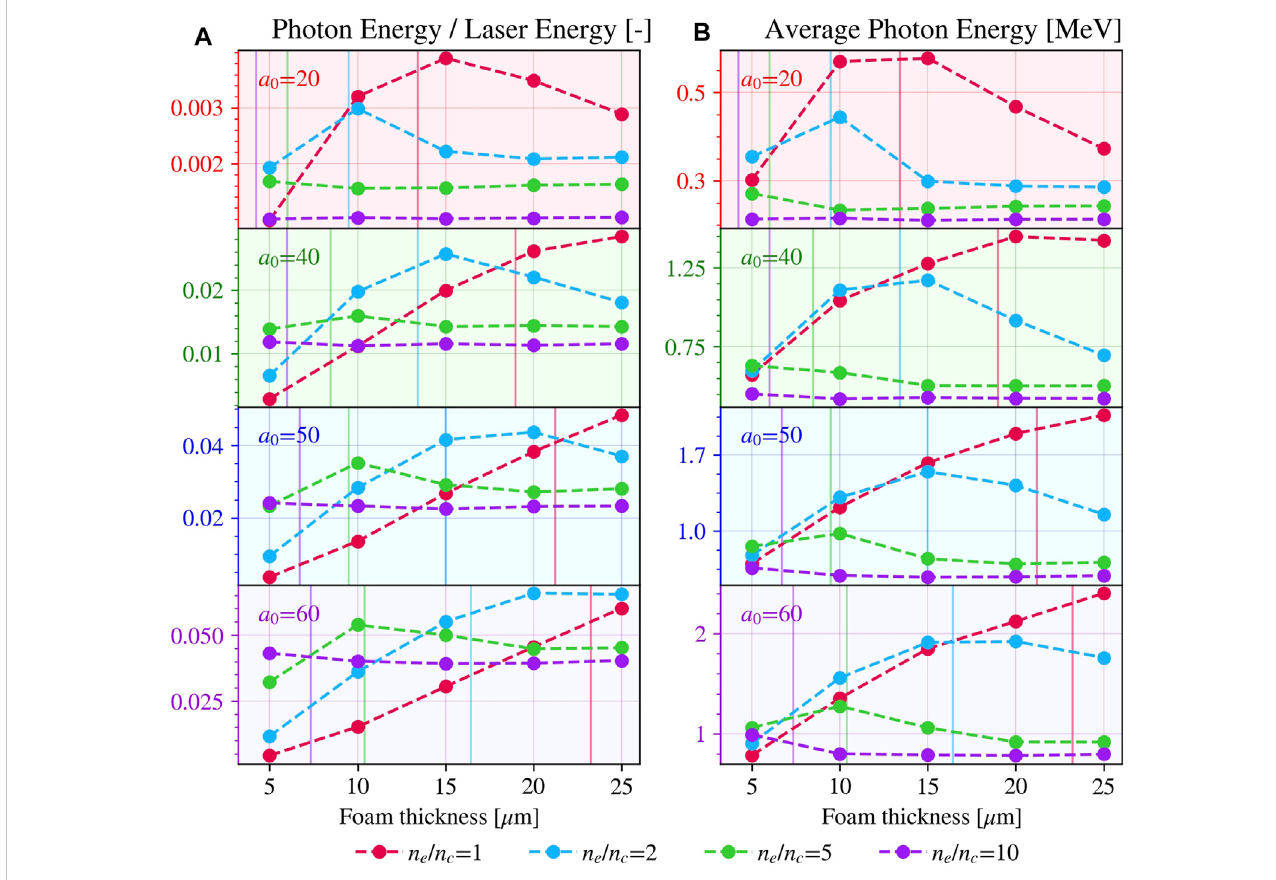
FIGURE 6 Conversionef fi ciencyofphotonenergyinlaserenergy (A) andaverageenergyofallemittedphotons (B) inallthesimulationsperformedvarying a 0 ,foam thickness and density ( n e /n c ). Every circle represents a simulation. Vertical lines colored according to the density values indicate the self-focusing length.